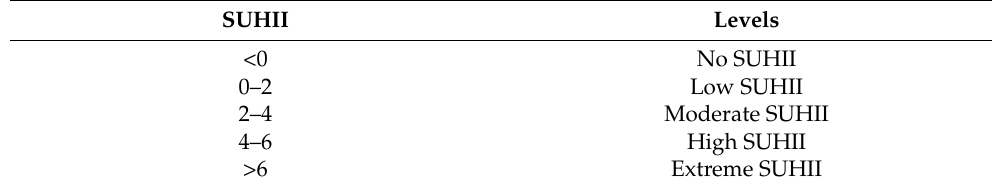
Table 1. SUHII classification standard [34].